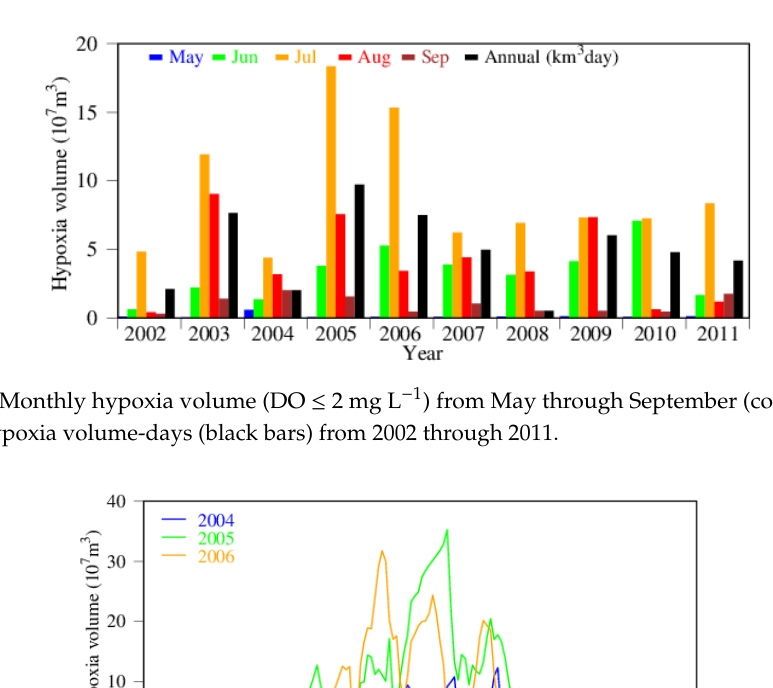
Figure 5. Monthly hypoxia volume (DO 2 mg L − 1 ) from May through September (color bars) and annual hypoxia volume ‐ days (black bars) from 2002 through 2011.